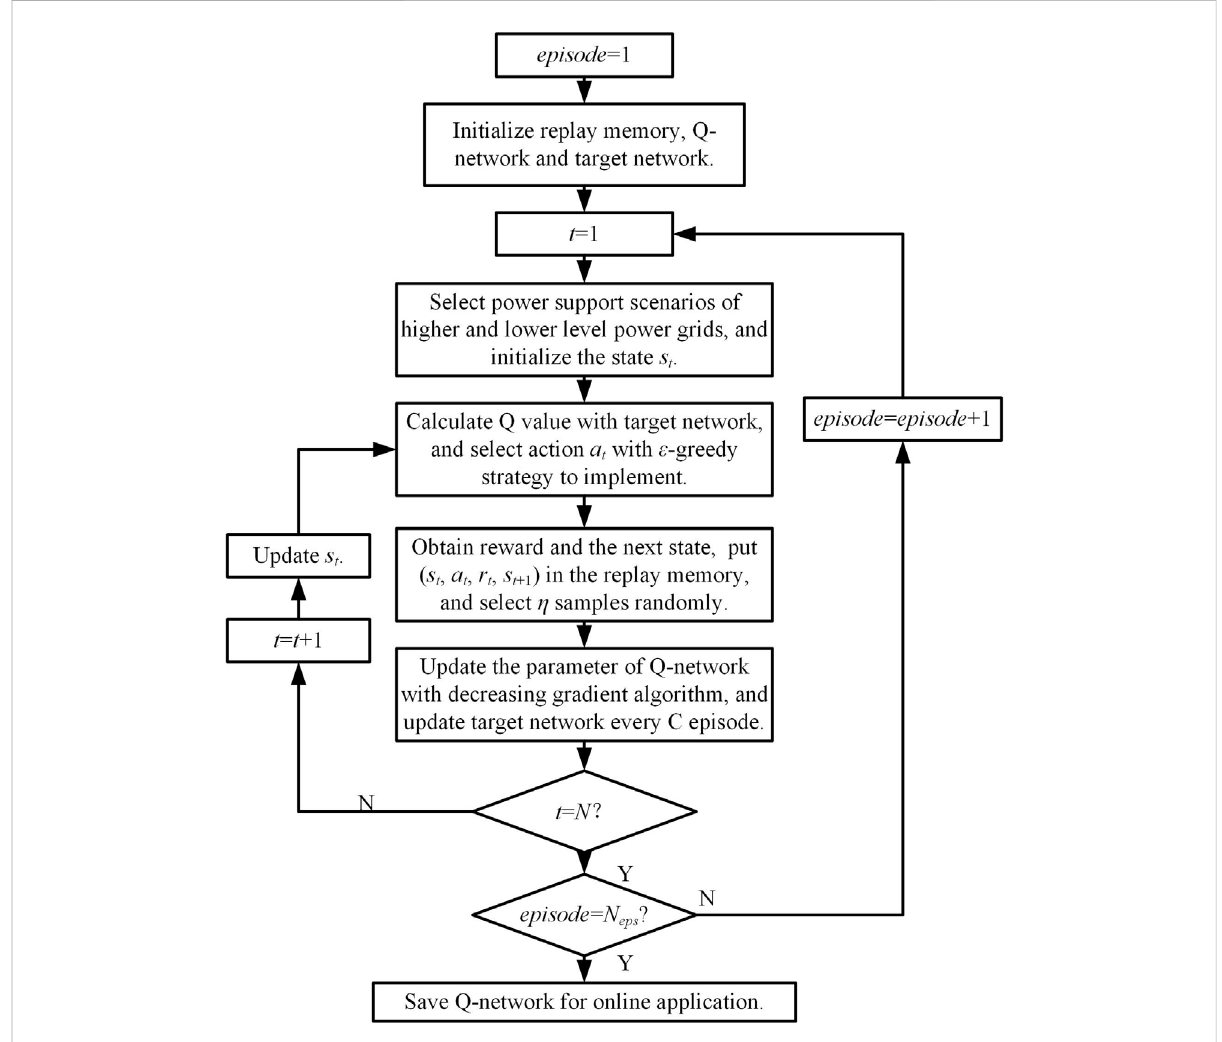
FIGURE 3 Flowchart of DQN training for distribution network con fi